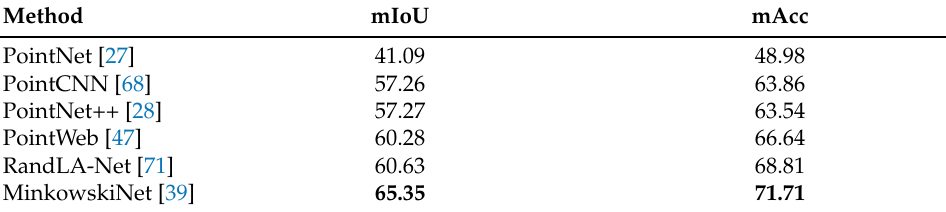
Table 3. Results of S3DIS Area-5 (%). The best scores in the table are marked in bold font.